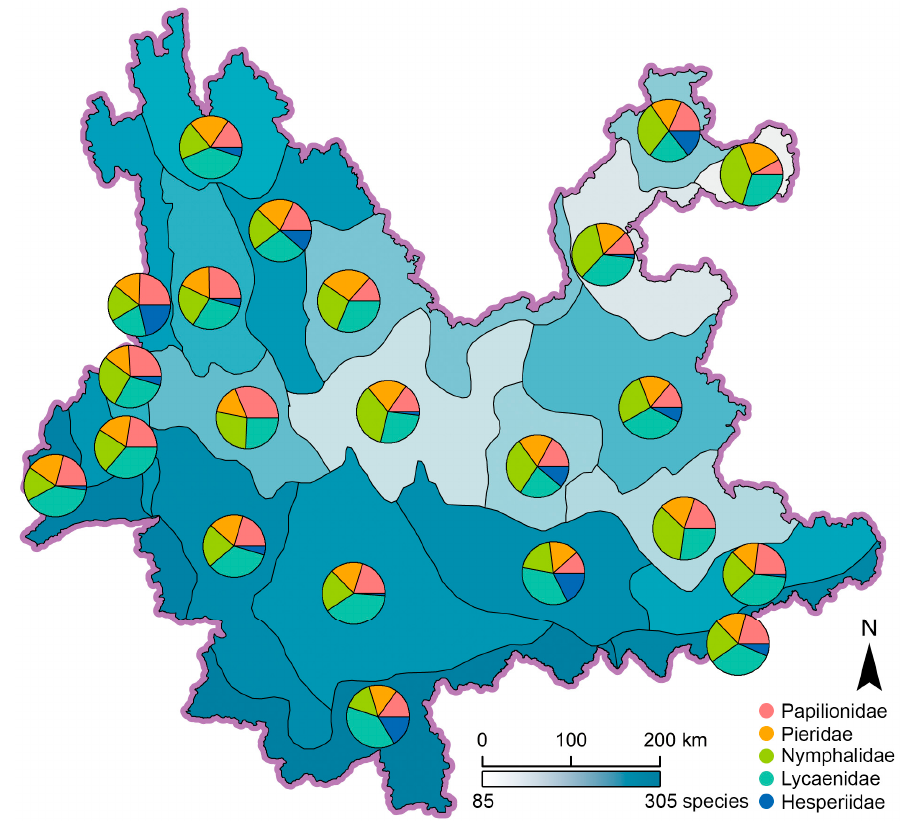
Figure 3. Spatial distribution of species richness in 22 ecoregions, pie charts represent the percentage of five butterfly